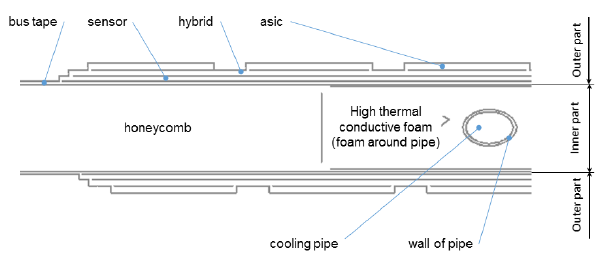
Figure 3. Inner and outer part of petal